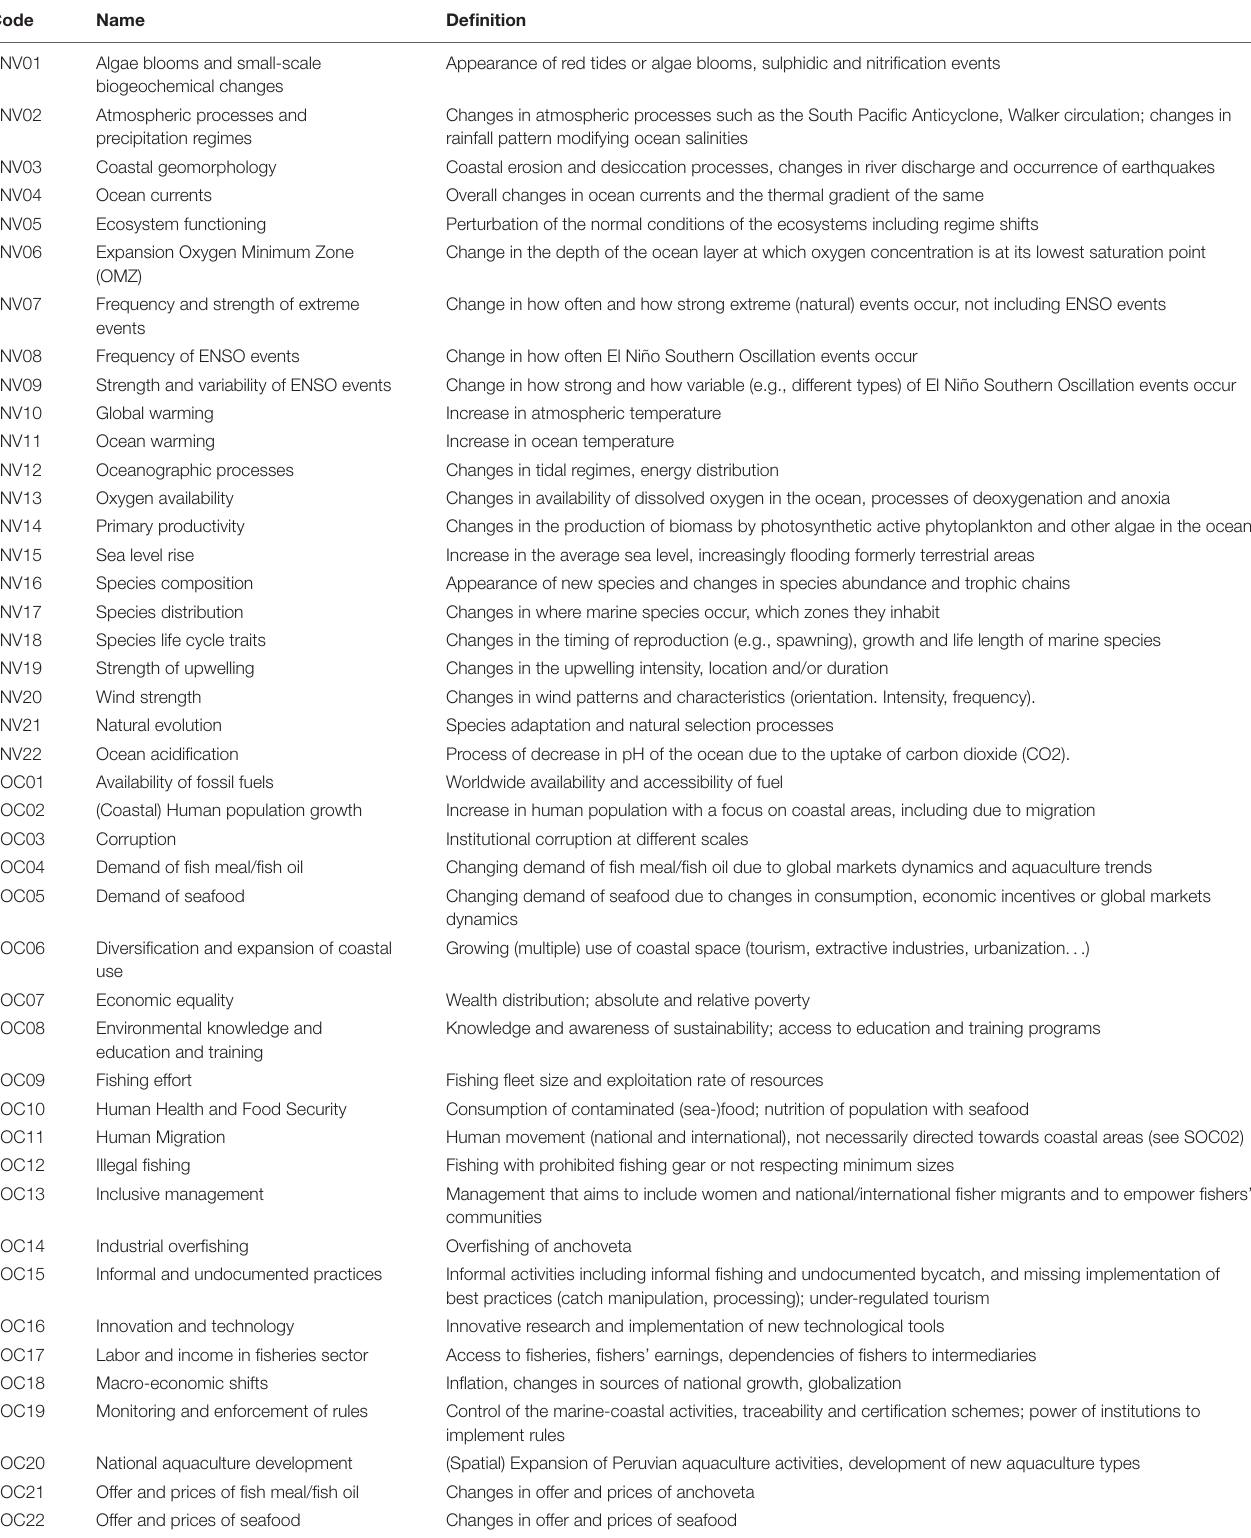
TABLE 1 | List of drivers resulting from the coding exercise analysis of the first step (cf. section “Identifying Drivers of Change: Reaching Out Through Online Surveys”.